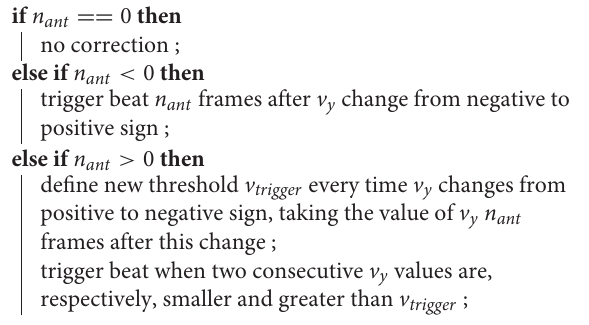
Algorithm 1: Correction of beat triggering for the TRAINED